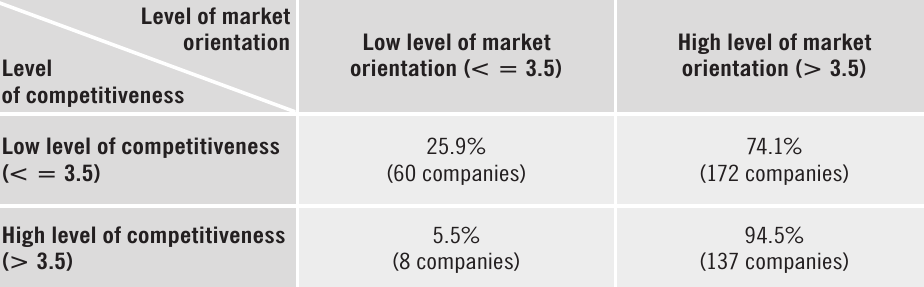
Table 15. Share of firms with a low and high level of market orientation among companies with a low and high level of competitiveness in